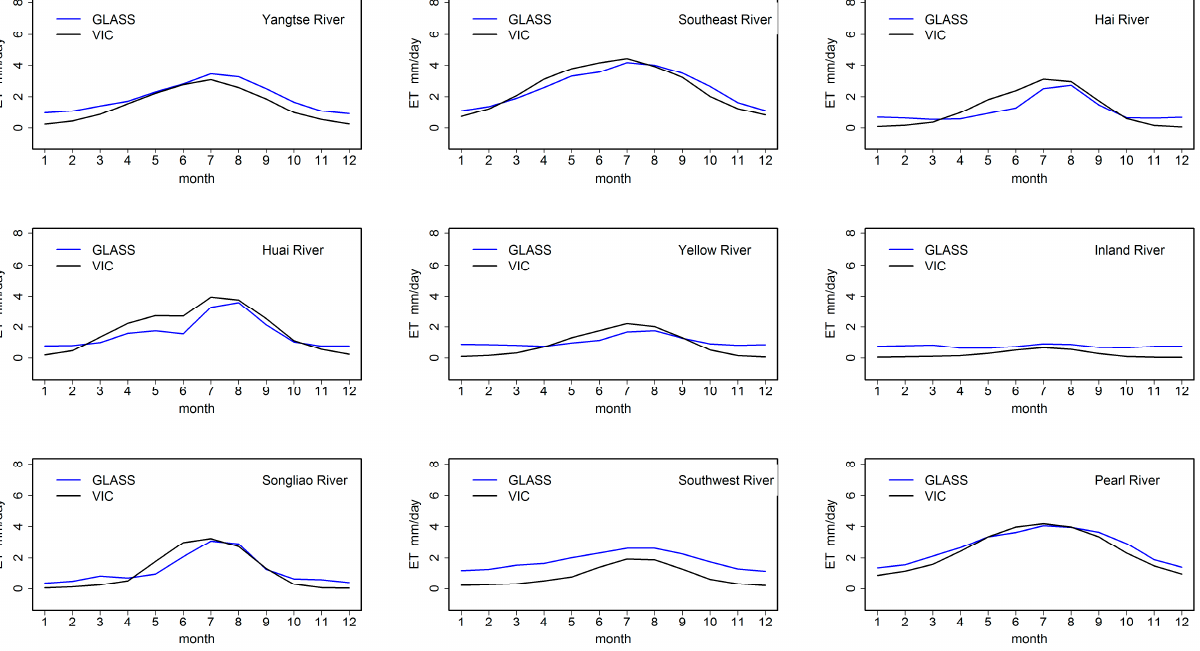
Figure 6. Comparisons of ET between the VIC simulation and the GLASS product of mean monthly ET for nine basins.